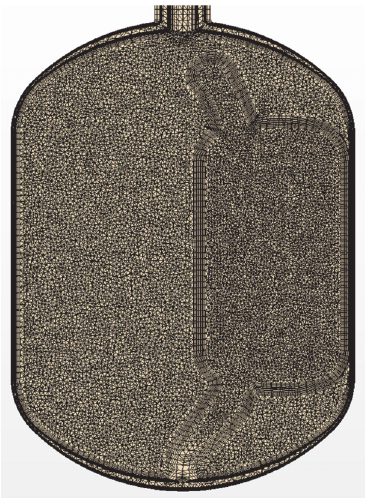
Figure 2: Mesh details of the moderator cell with expansionary and unstructured